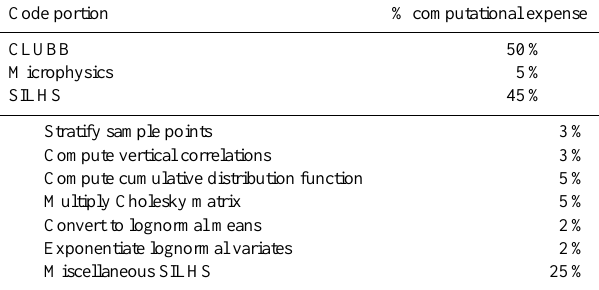
Table 1. Relative computational expense of SILHS, CLUBB, and the KK microphysics. Two sample points per grid box and time step are drawn. The cost of SILHS is broken into various sub-costs. This simulation was run on a single processor. The code was compiled using the SunStudio Fortran compiler under the Linux operating system, and the timing was performed by Sun Analyzer